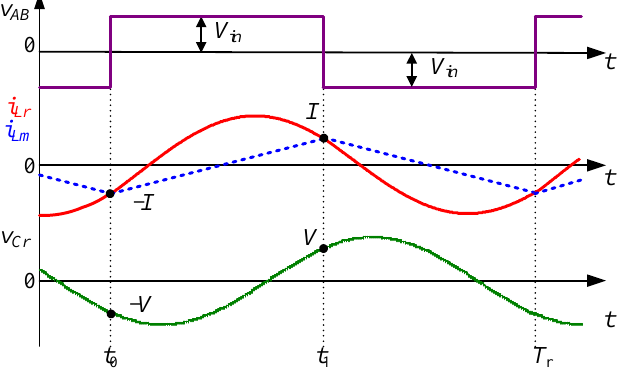
Figure 2. Waveforms of LLC resonant converter at resonant frequency in the ideal case.